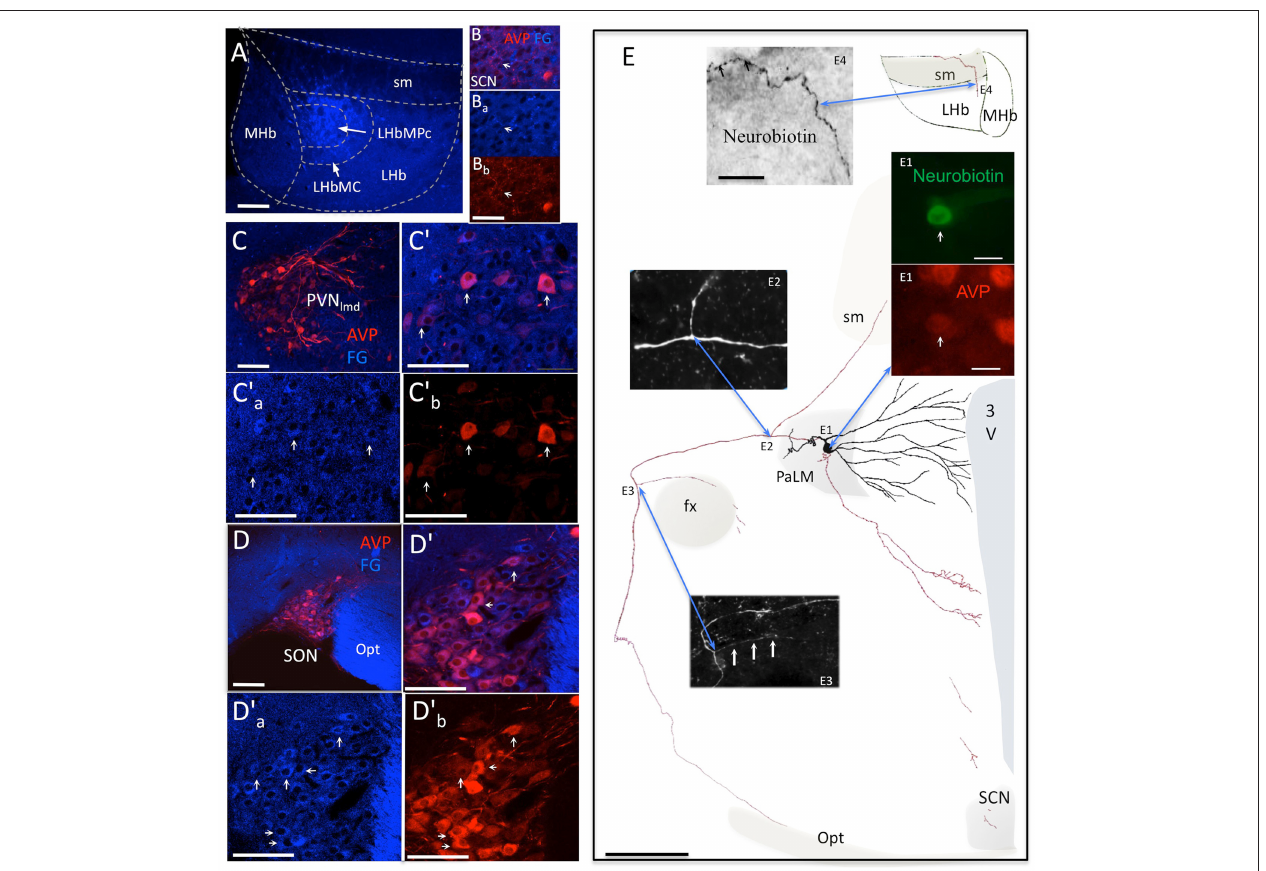
FIGURE 3 | AVP containing magnocellular neurosecretory neurons serving as one of the sources of AVP+ axons in LHb. (A) Fluoro-Gold (FG) retrograde tracer was injected in the medio-central subnucleus of the lateral habenula (LHbMC). (B) In the hypothalamic suprachiasmatic nucleus (SCN, panels B ′ a–b ), only sparse double-labeled cellular components were found. (C) Numerous FG + /AVP + somata were found in hypothalamic paraventricular nucleus (PVN, (C ′ ) shows an magnification of the region and ( C ′ a ) and (C ′ b ) are the separated channels). Arrows indicate some double-labeled cells. (D) , (D ′ ), (D ′ a ), and (D ′ b ). Same cases of Cs but in the hypothalamic supraoptic nucleus (SON). ( E) camera lucida reconstruction of an in vivo juxtacellularly labeled AVP + magnocellular neuron. The soma and dendrites were represented in black and axonal segments were represented in red. AVP-containing nature was ascertained by AVP immunoreaction (E1). The soma gave rise initially to two short thick primary dendrites, which branched proximally. The main axon coursed laterally passing the fornix (fx), turned ventro-caudally toward the posterior pituitary gland. Two main collaterals emanated from this axon (E2,E3). The first collateral (E2) coursed dorsomedially joining the stria medularis (sm). Neurobiotin labeled processes were found inside the lateral habenula (E4). [The panel (E) was modified from ( Hernández et al., 2015)]. 3V: third ventricle; Opt: optic tract; SCN: suprachiasmatic nucleus; PaLM: paraventricular lateral magnocellular. Scale bars: A, C ′ , C ′ a–b, and D ′ , D ′ a–b : 100 µ m; B ′ a–b : 20 µ m; E : 250 µ m; E1 : 20 µ m, and E4 : 50 µ